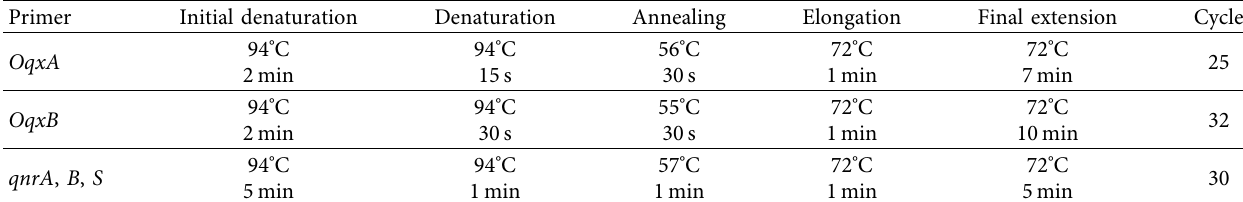
Table 1: PCR program for detection of oqx A and oqx B and qnr genes. Primer Initial